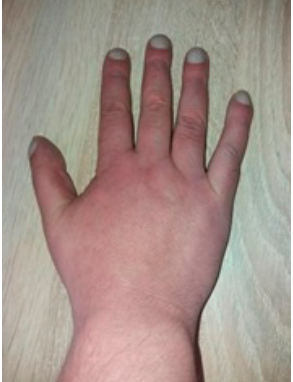
Figure 1. Clubbing of the fingers.